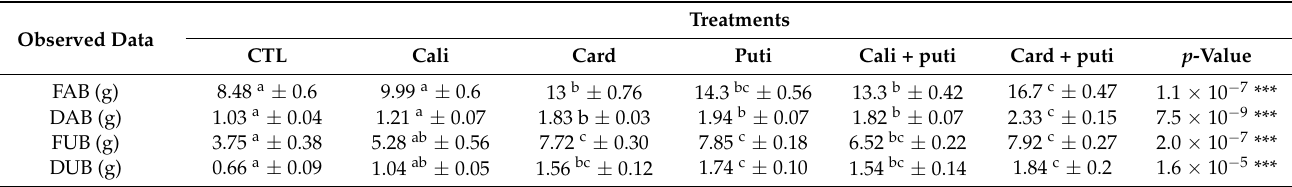
Table 3. Mean value ( ± standard error) of the effect of chitosans produced in combination with P. putida on the biomass yield parameters of maize plants. Observed Data